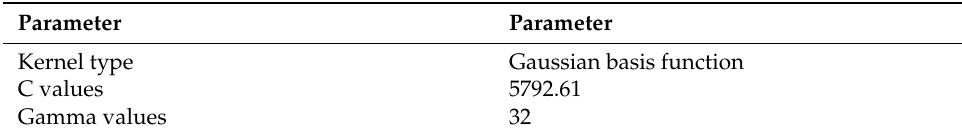
Table 2. The selected input parameters of